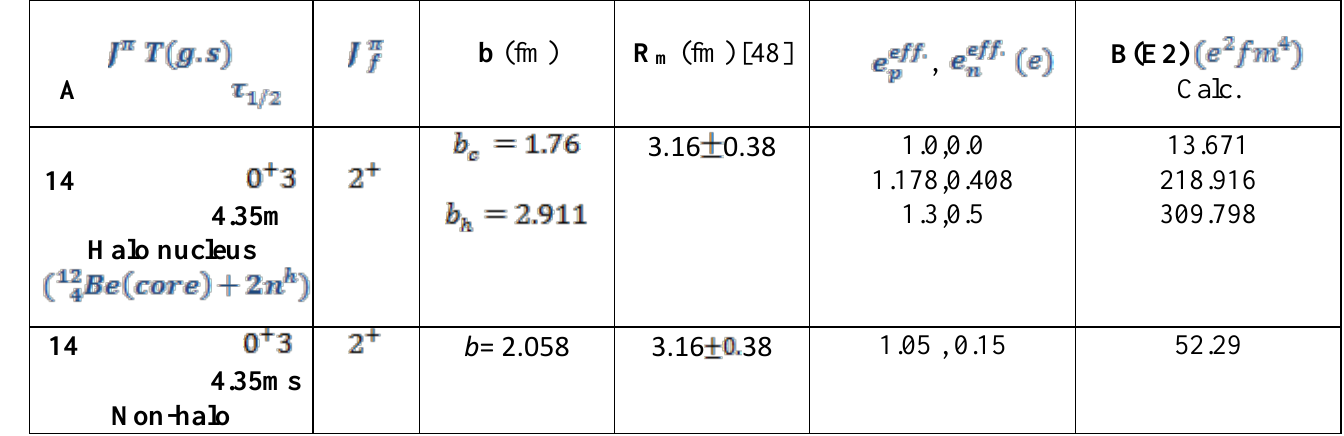
Table 4: The calculated effective charges and B(E2) values of 14